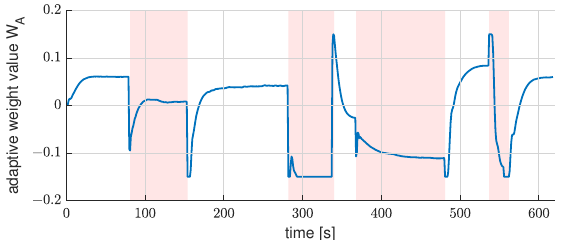
Figure 22. The change in the adaptive weight value for each leg of the course during